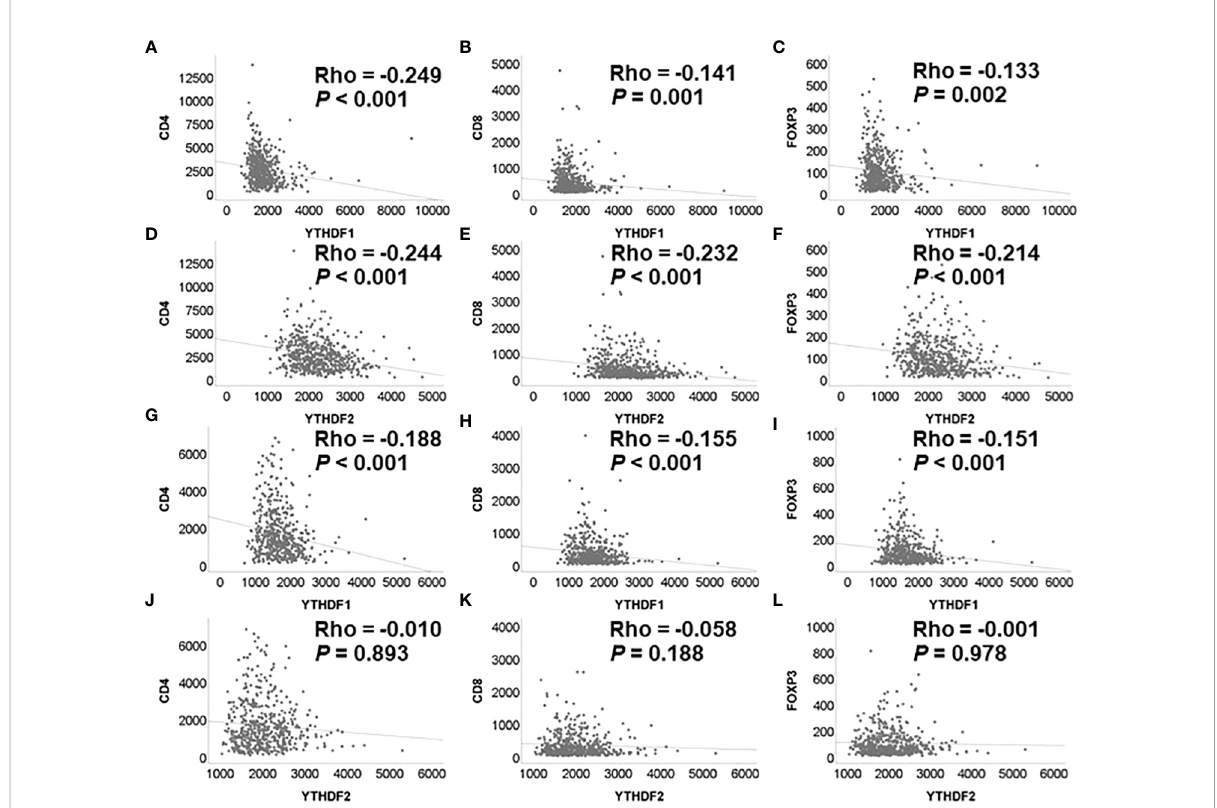
FIGURE 2 Correlation among YTHDF1, YTHDF2, CD4, CD8, and FOXP3 analyzed by mRNA expression in PD-1 inhibitor non-treatment groups. (A) YTHDF1 and CD4 in adenocarcinoma. (B) YTHDF1 and CD8 in adenocarcinoma. (C) YTHDF1 and FOXP3 in adenocarcinoma. (D) YTHDF2 and CD4 in adenocarcinoma. (E) YTHDF2 and CD8 in adenocarcinoma. (F) YTHDF2 and FOXP3 in adenocarcinoma. (G) YTHDF1 and CD4 in squamous cell carcinoma. (H) YTHDF1 and CD8 in squamous cell carcinoma. (I) YTHDF1 and FOXP3 in squamous cell carcinoma. (J) YTHDF2 and CD4 in squamous cell carcinoma. (K) YTHDF2 and CD8 in squamous cell carcinoma. (L) YTHDF2 and FOXP3 in squamous cell